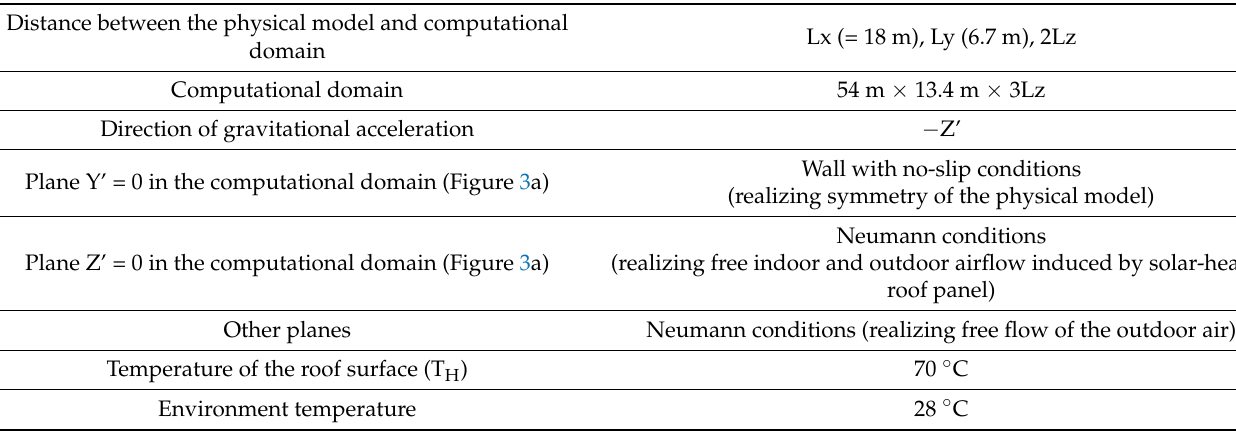
Table 2. Parameters specified in the numerical calculations. (Figure 3a).